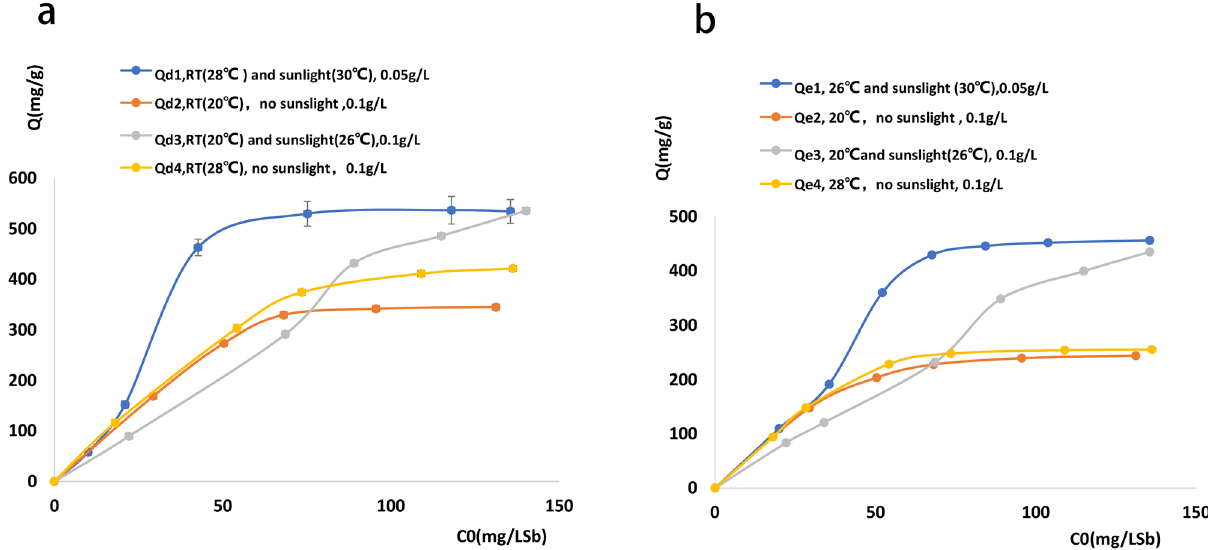
Figure 14. Effect of light, temperature, and dosage on removal of antimony pentavalent from water of the synthetic materials NZV-FEZn ( a ) and rGO/NZV-FeZn ( b